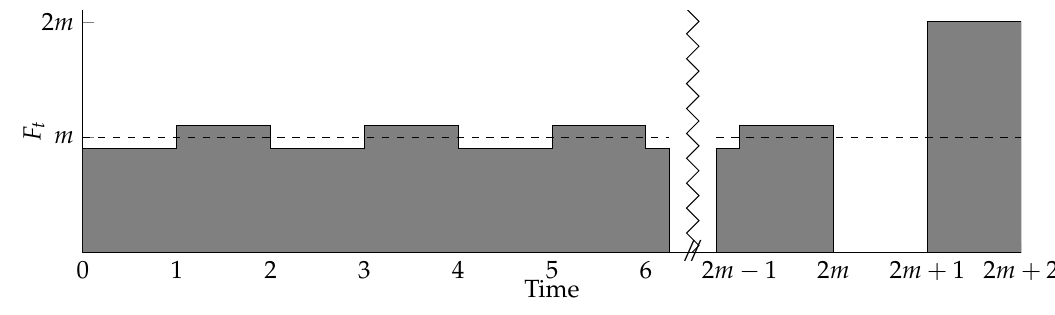
Figure 4. The flow values and the bound for Example